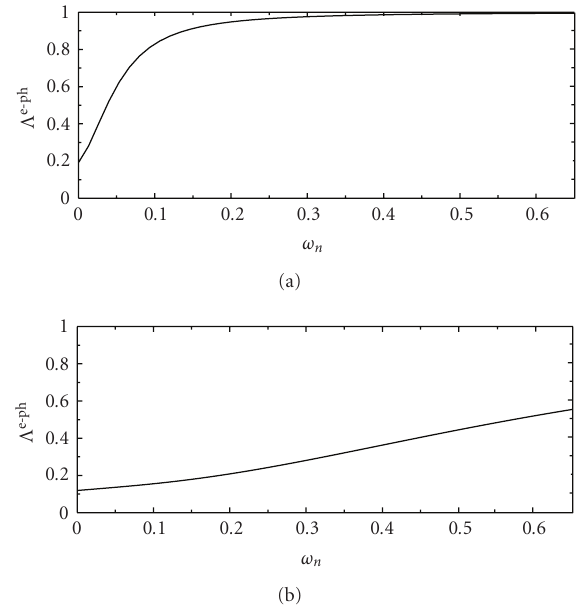
Figure 3: E ff ective e-ph vertex in units of the bare e-ph coupling as a function of the Matsubara frequency in the HH model at leading order in 1 /N . The parameters are the same as in Figure 2. Panel (a) is for a small transferred momentum q = (0 . 2,0) (in units of inverse lattice spacing 1 /a ); (b) is for a sizable transferred momentum q = (2 . 0,0) (after